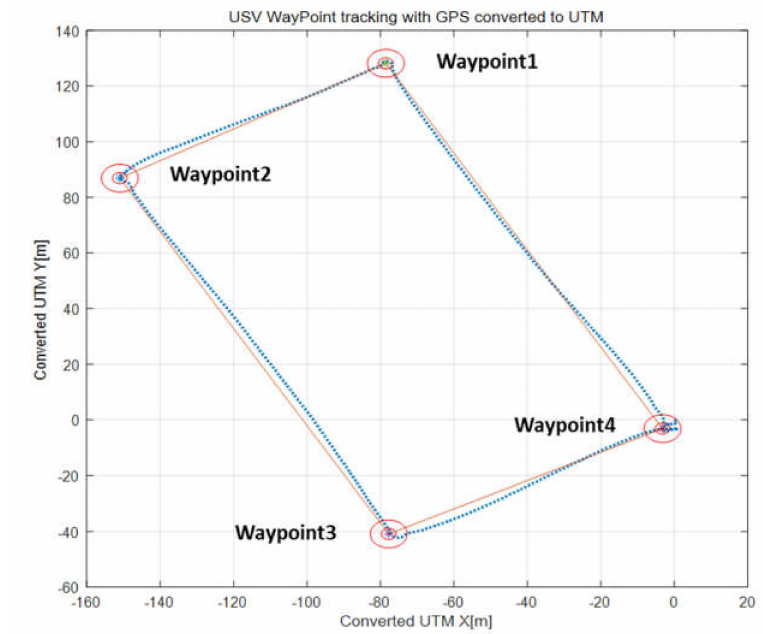
Figure 24. Trajectory during waypoint tracking. UTM, universal transverse